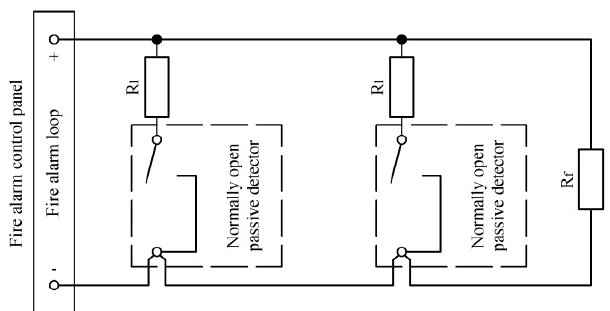
Figure 6. Wiring diagram for normally open FA in a two-wire loop R l – load resistor; R f – final resistor